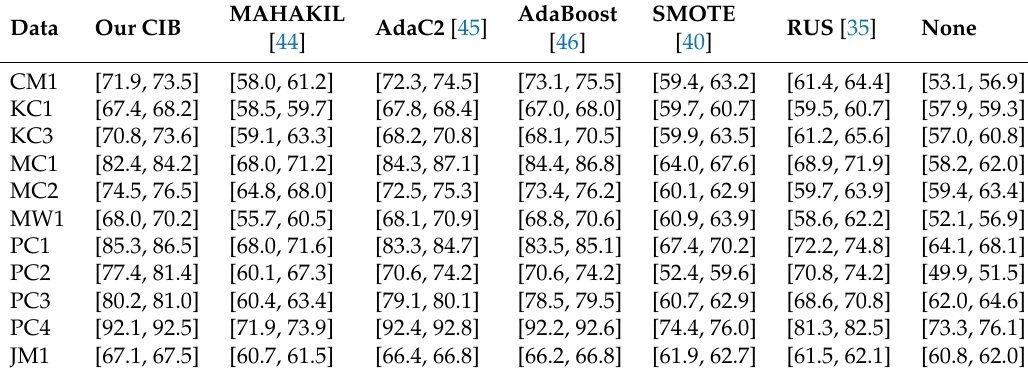
Table 11. 95% confidence interval of AUC for CIB and the baselines on 11 NASA datasets.